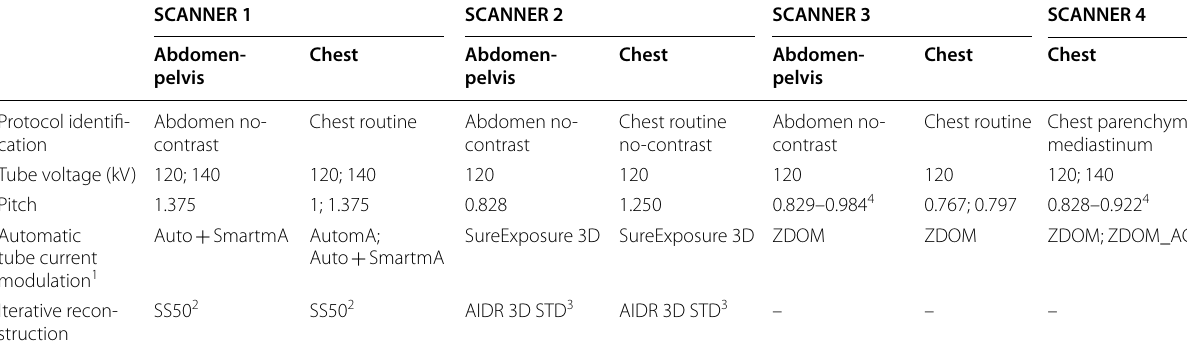
Table 1 The main acquisition parameters of the examination’s protocols evaluated for each CT scanner